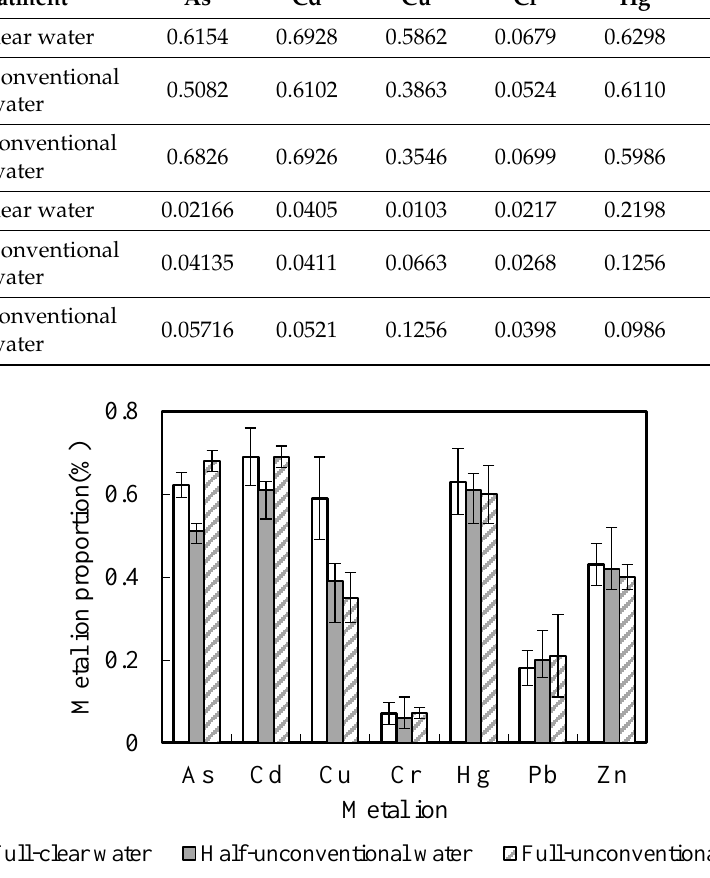
Figure 3. Heavy metals take-away proportions account for total volume in soil. %.